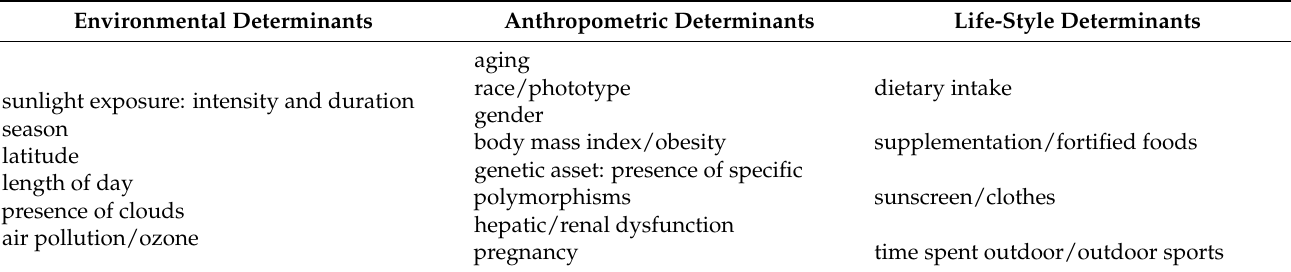
Table 2. Environmental, anthropometric, and lifestyle determinants affecting 25(OH)D